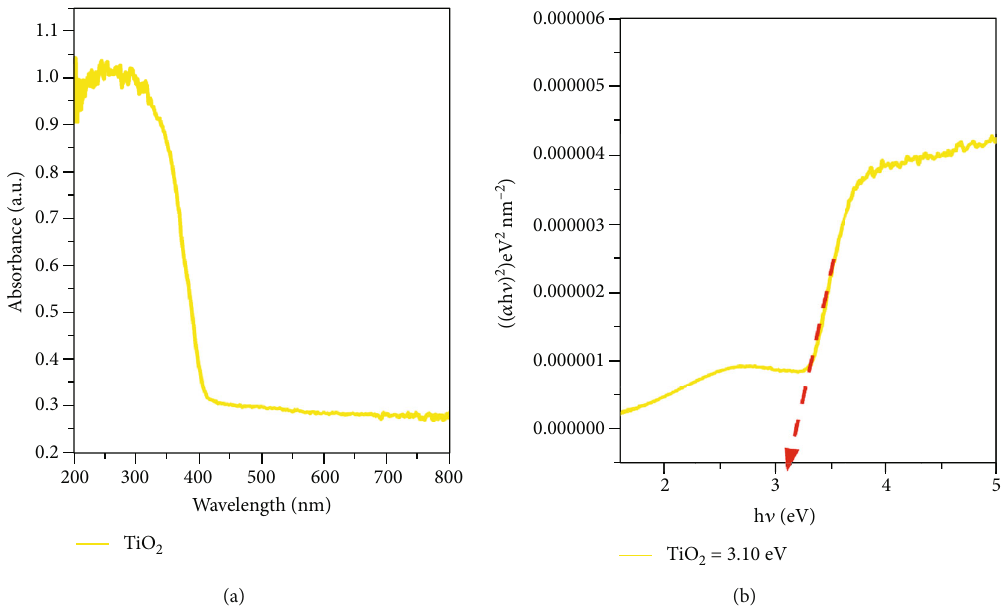
Figure 5: (a) Spectrum of UV-DRS absorption of biosynthesized TiO